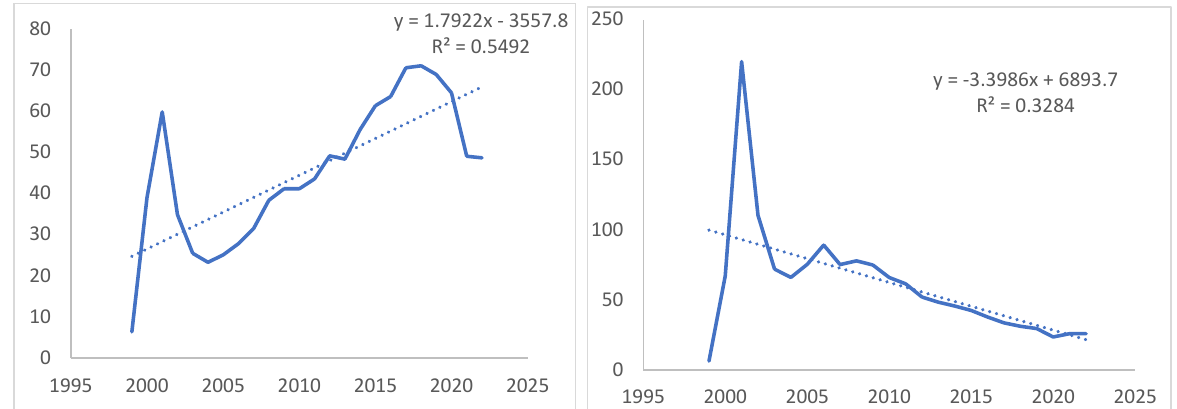
Figure 1. Linear regression trend of HIV incidence on 100,000 inhabitans in Russia ( left ) and St. Petesburg ( right ).